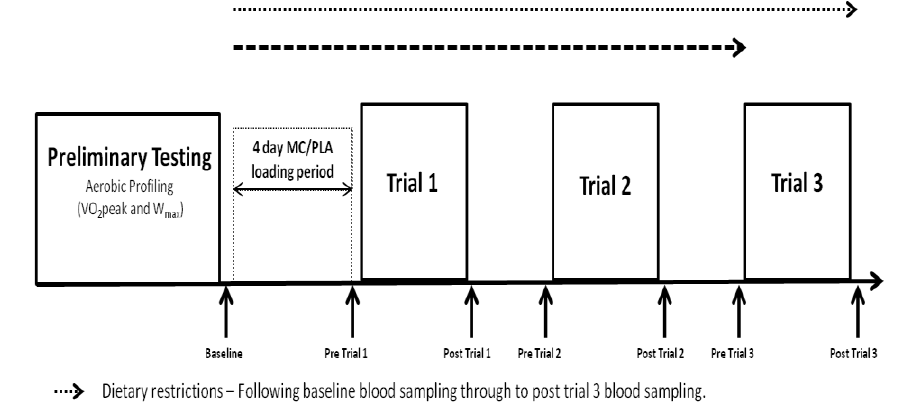
Figure 1. Schematic of testing protocol. Trials took place on consecutive days at 8:00